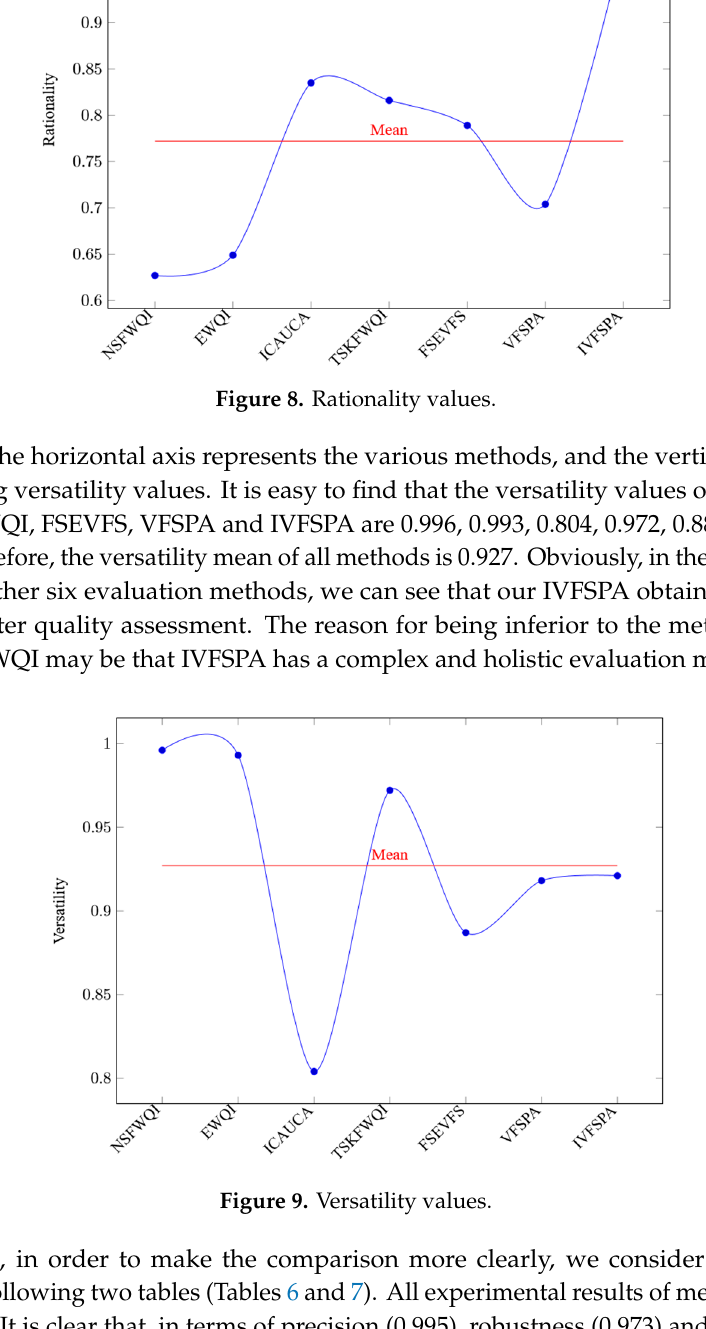
Table 6. Experimental results of metrics validation.